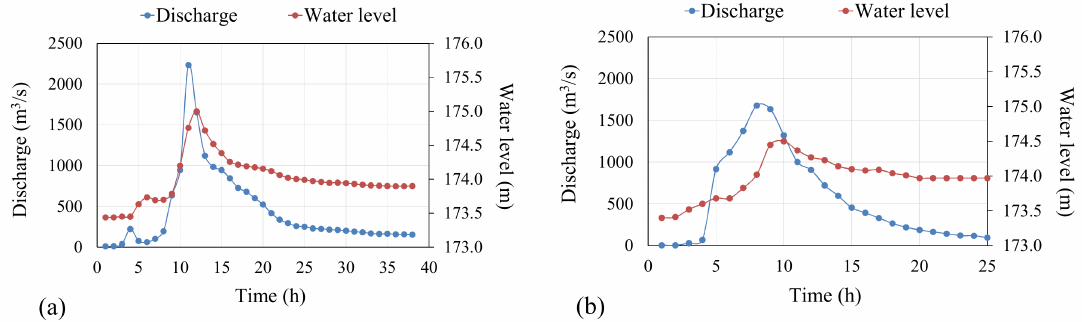
Figure 6. Boundary conditions for the test events of Typhoons ( a ) Nesat and ( b ) Maria.